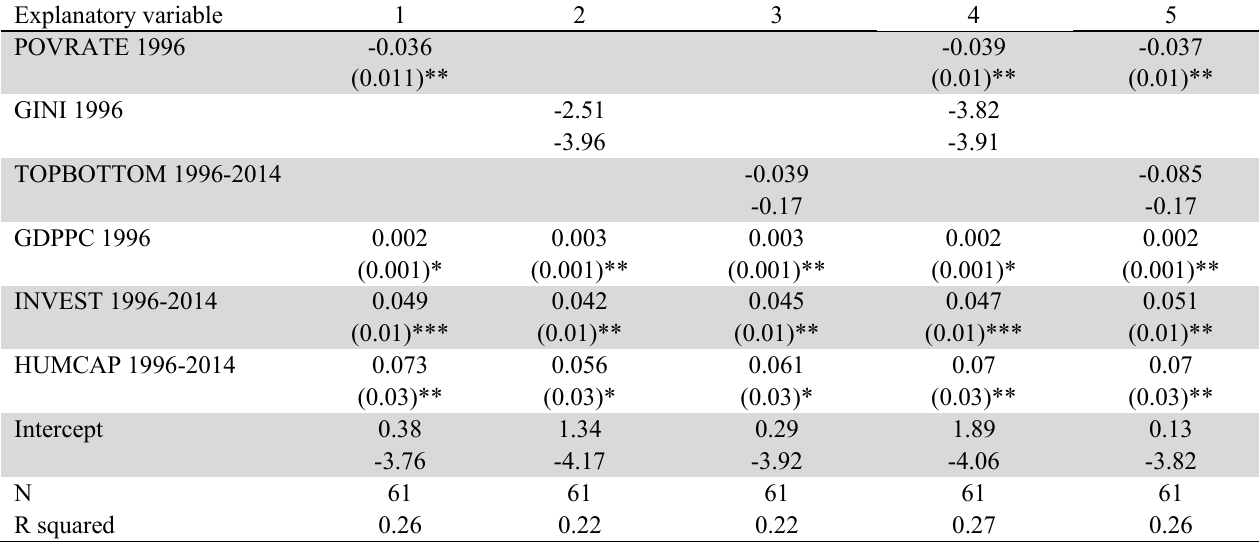
The impact of poverty and inequality on